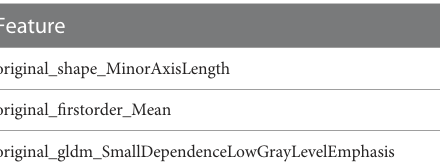
TABLE 2 ICC values of selected image omics features.